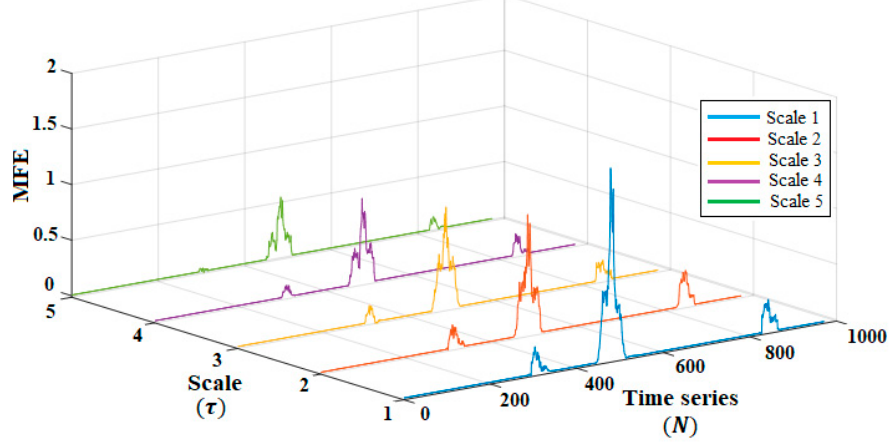
Figure 11. MFE under different scales of PF 1 .